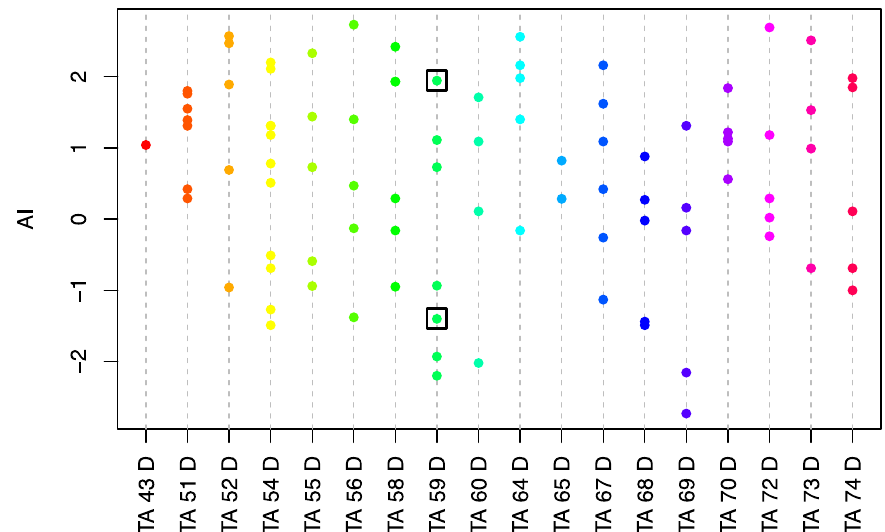
Figure 1. The phenotypic analysis using the in vitro test revealed a range of AI values within the Elaeis oleifera population (93 individuals phenotyped from 18 progenies). Each colored circle represents the average AI value for a single individual. Negative AI values reflect a low competence for the AZ to undergo cell separation, while positive AI values indicate a high AZ cell separation competence. The boxed green circles are the two individuals with contrasted abscission phenotypes selected for the transcriptome analysis. The green boxed circle with the negative AI is the non-shedding individual selected for the transcriptome analysis because it does not shed its fruit under field conditions, and seed germination can be observed (Figure 2).